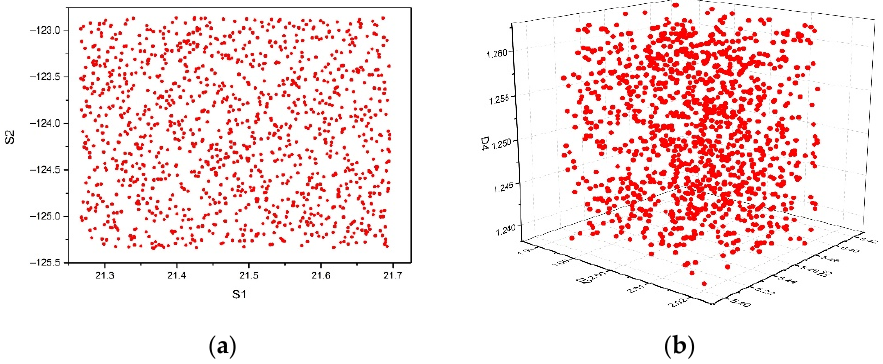
Figure 5. Projection of sample points in 2D and 3D spaces: ( a ) 2D (S1 X S2) space; ( b ) 3D (D2 X D3 X D4) space.